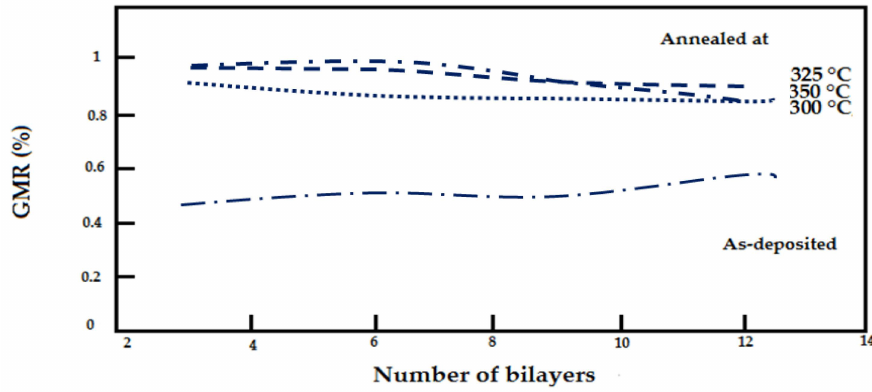
Figure 16. The annealed GMR multilayer in a vacuum at 300 ˝ C, 325 ˝ C and 350 ˝ C. by Siritaratiwat et al.